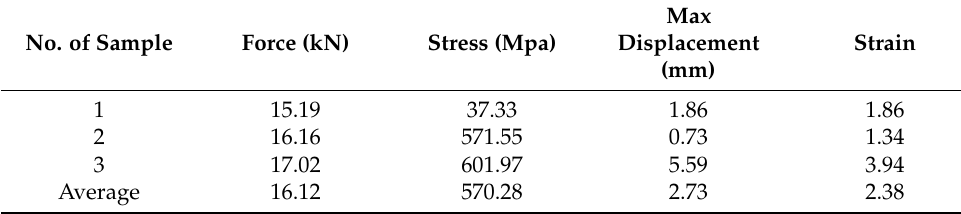
Table 7. Results for 6 mm-diameter steel bars.